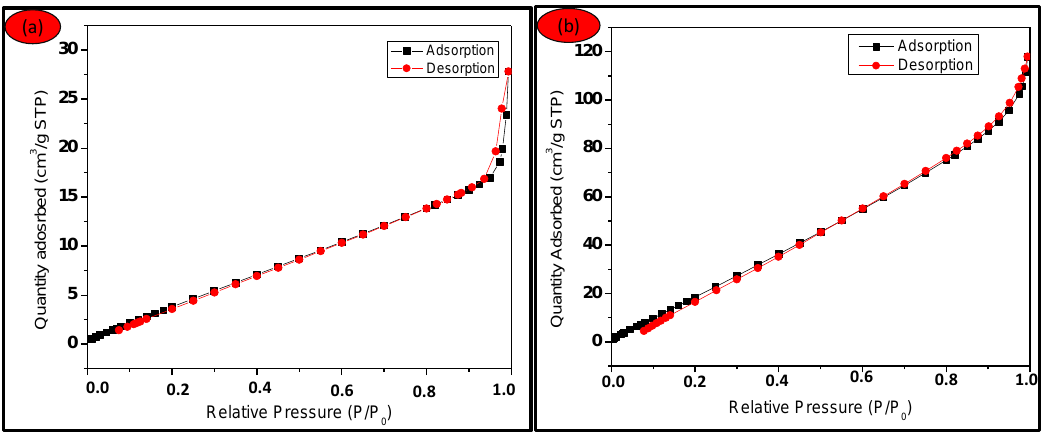
Figure 6. N 2 adsorption-desorption isotherm for ( a ) SCBA nano CA-Silica and ( b ) SCBA nano L-cys Silica.